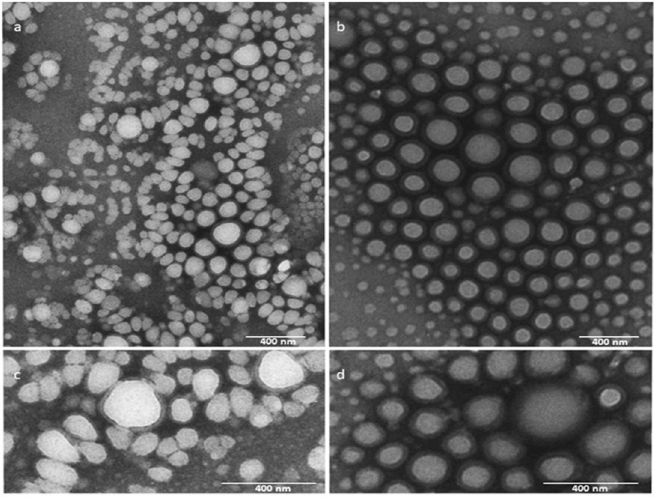
Figure 7. TEM images of empty Nps (blank) and FS10-loaded Nps. Empty Nps ( a , c ); FS10-loaded Nps ( b , d ). ( c , d ) are high magnification. Nps ( b , d ). ( c , d ) are high